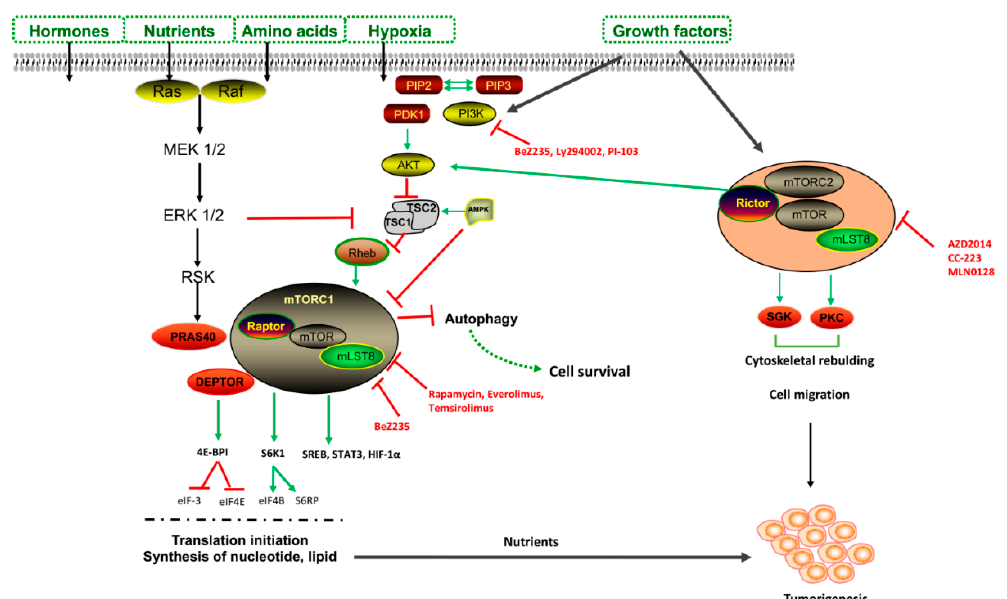
Figure 2. Schematic representation of mechanistic target of rapamycin complex 1 (mTORC1) and mTORC2 pathways and point of inhibition. mTORC1 associates with endosomal and lysosomal membranes via its effector, mTORC2. Once phosphorylated, AKT can activate mTORC1 directly, either by phosphorylating and dissociating the proline-rich Akt substrate of 40kDa (PRAS40) from the regulatory-associated protein of mTOR (RAPTOR) or by inhibiting tuberous sclerosis (TSC)1/2 complex formation, releasing the Ras homolog enriched in brain (RHEB), which is an activator of mTORC1. Protein translation and the synthesis of nucleotide lipid via 4E-BP1 and S6K1 is regulated by mTORC1. In tumorigenesis, mTORC2 activates signal transducer and activator transcription (STAT3), hypoxia-inducible factor 1a (HIF1a), and protein phosphatase 2A (PP2A). In addition, mTORC2 regulates serum glucose kinase (SGK) and protein kinase (PKC) to induce cell survival, cytoskeleton organization, and cell migration. mTORC1 functions as a negative regulator of autophagy, exerting its inhibitory action by phosphorylating and inactivating ULK1 / 2 and